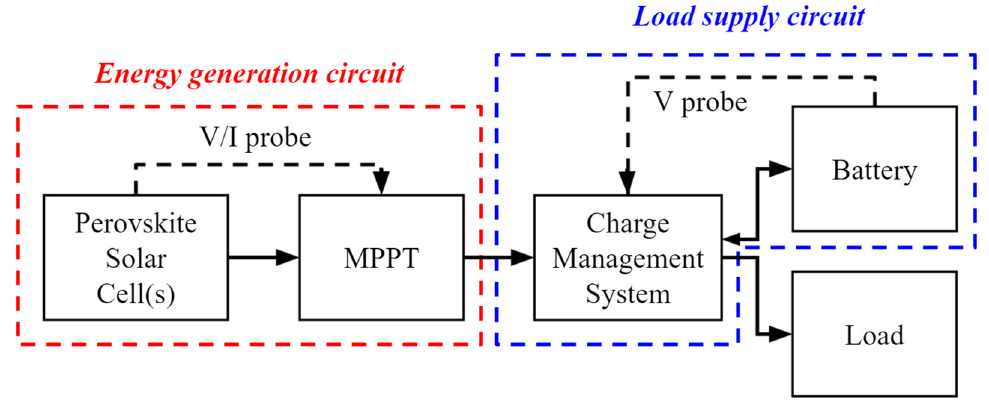
Figure 1. The proposed perovskite PV energy harvesting system.